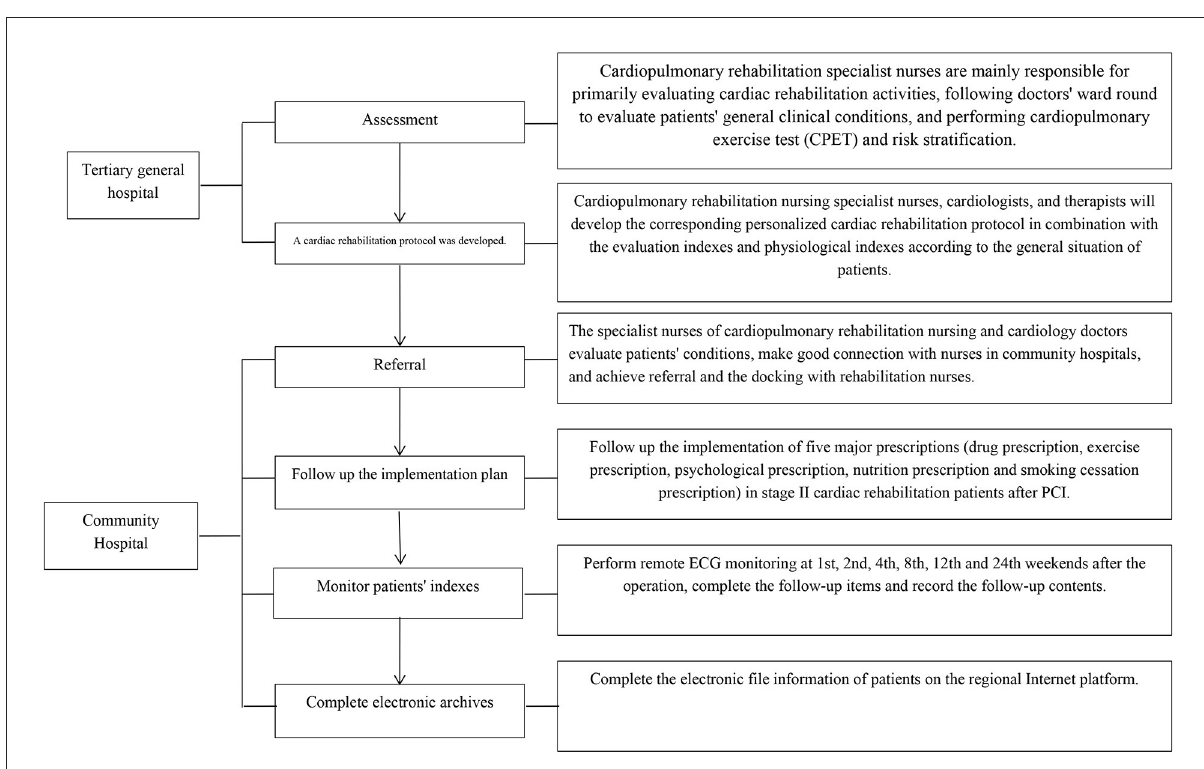
FIGURE1 Continuous nursing cardiac rehabilitation mode based on hierarchical diagnosis and treatment-Tertiary General Hospital-Community